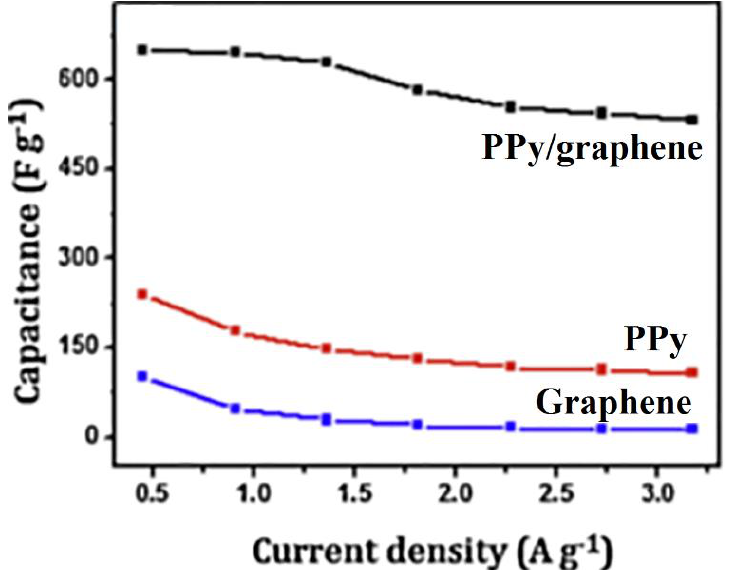
Figure 8. Specific capacitance curves of graphene, PPy, and PPy/graphene at varying current densi- ties [87]. PPy = polypyrrole. Reproduced with permission from Elsevier.